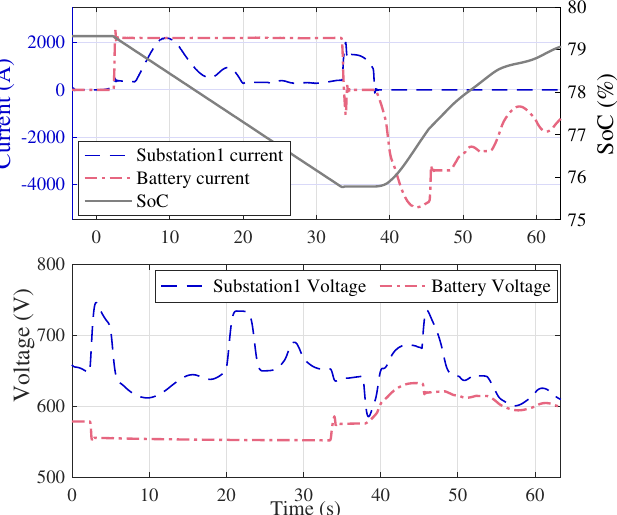
Figure 16. Substation1 and Battery Current, Battery SoC, Substation1 and Battery Voltage for 45% energy saving with standalone